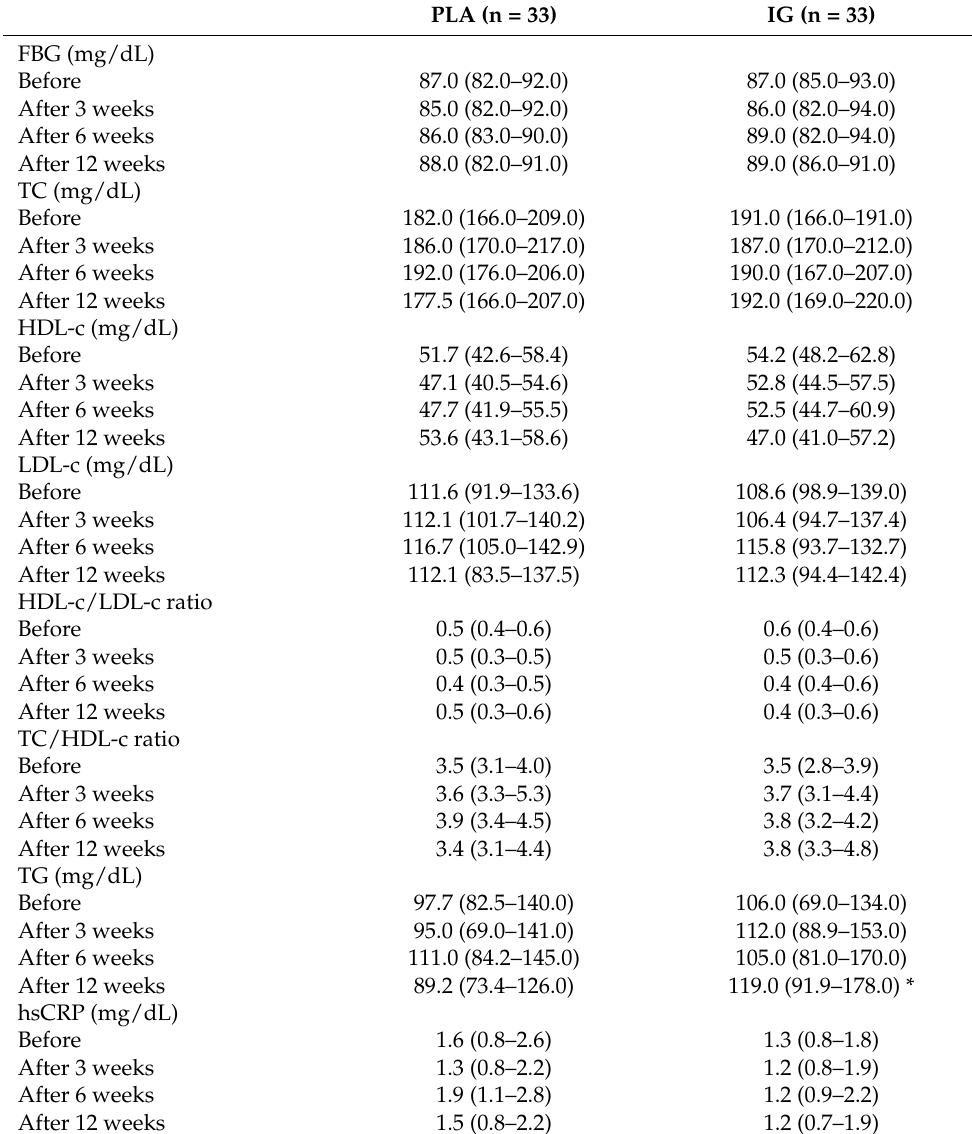
Table 5. FBG and plasma lipid profile before and after supplementation for 3, 6, and 12 weeks in both